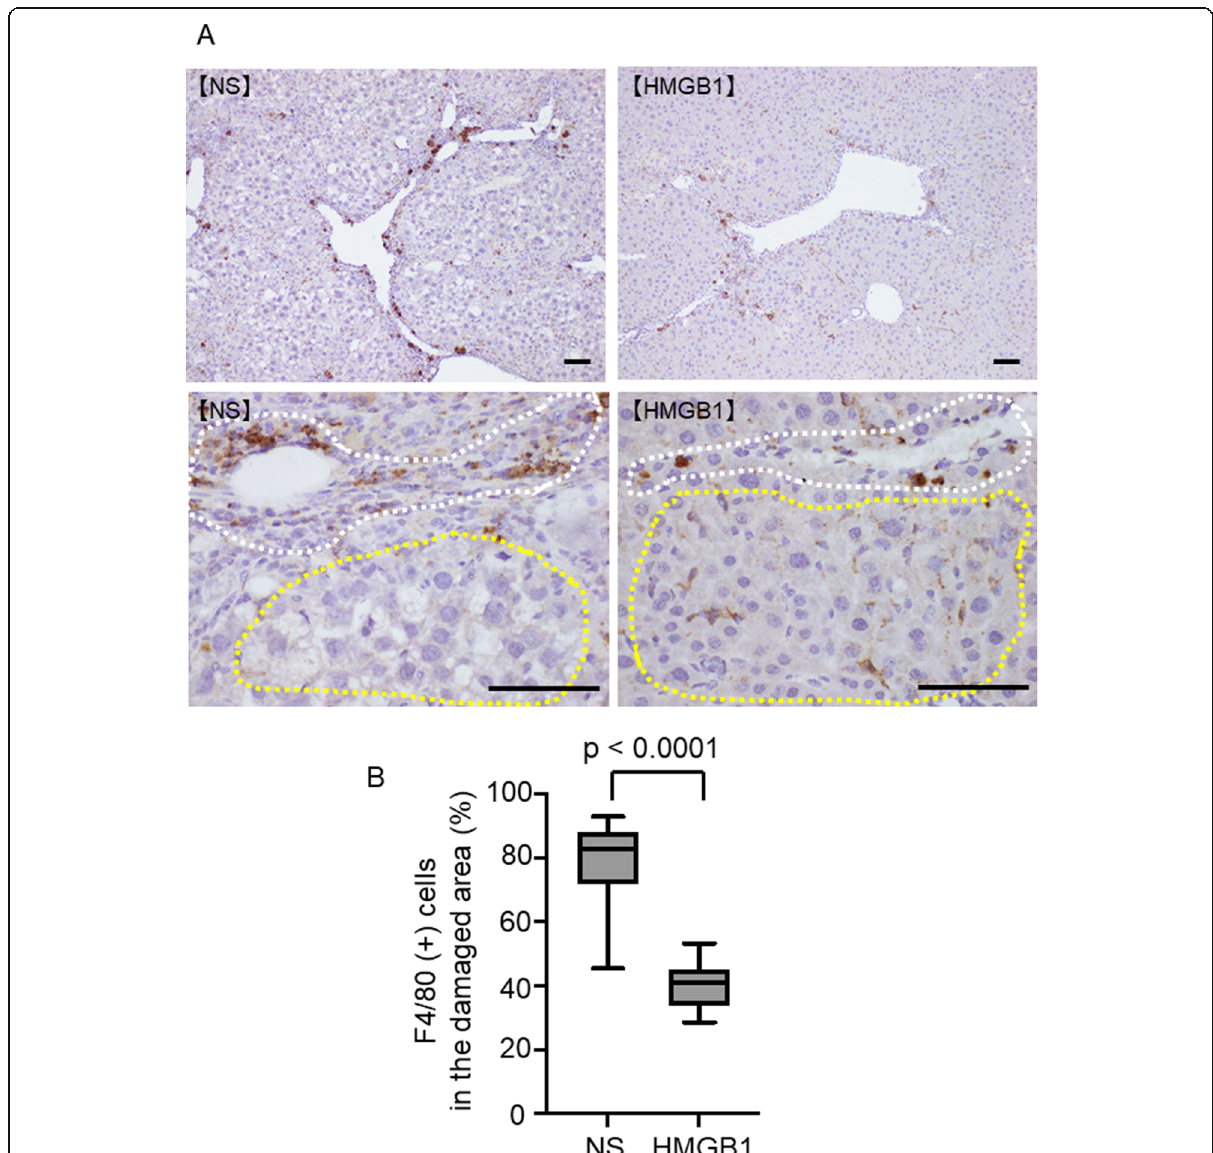
Fig. 7 Immunostaining of liver tissues. A Immunostaining using F4/80 4 weeks after the treatment of NS or HMGB1 peptide is shown. B The frequency of F4/80+ cells in the damaged area is shown. White dotted circle, damaged area; yellow dotted area, parenchyma. Scale bar = 100 μ m. n = 5 in each group. Data are presented as means ± standard